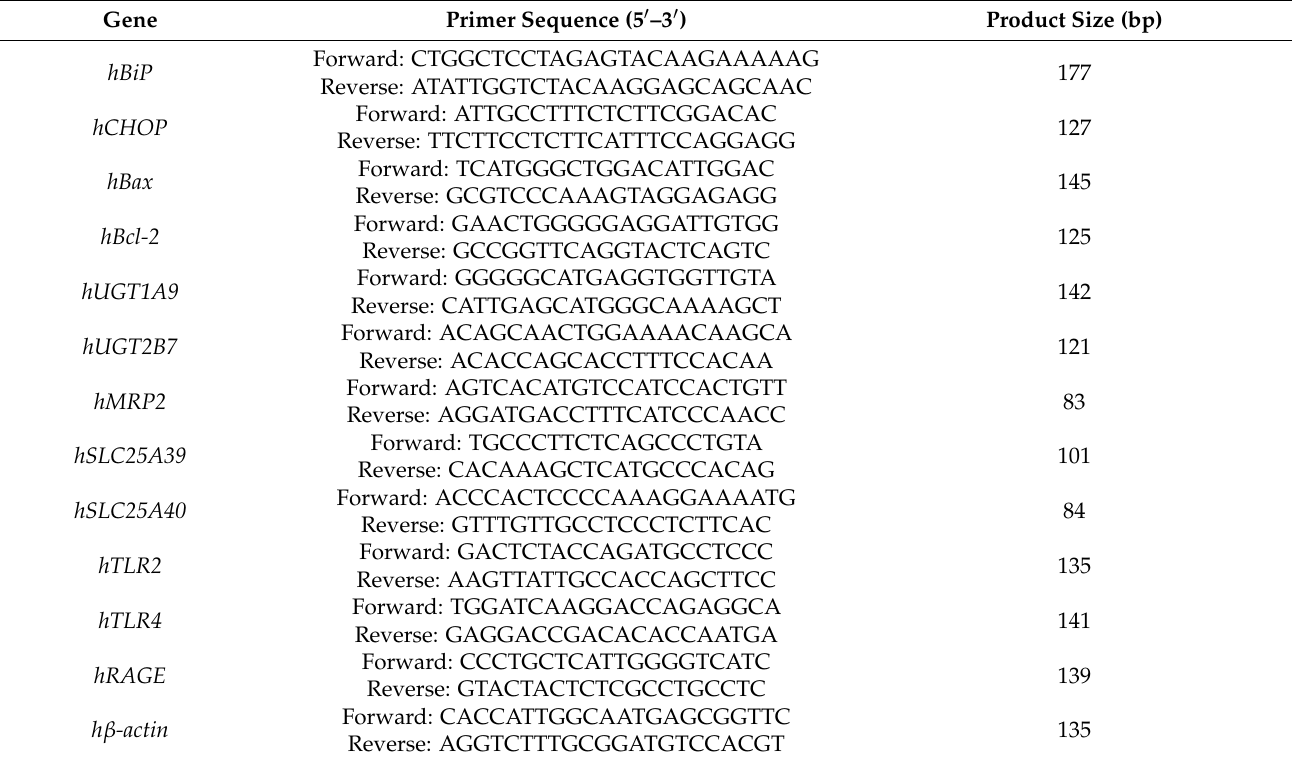
Table 2. Primer sequences used in RT-PCR